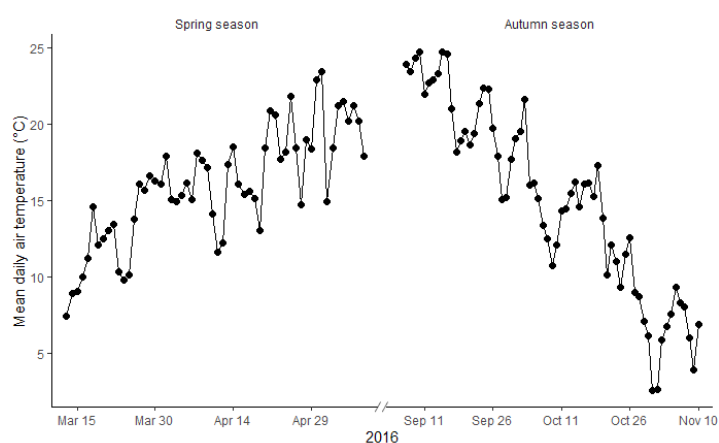
Figure 1. The mean daily air temperature during the two growing seasons.